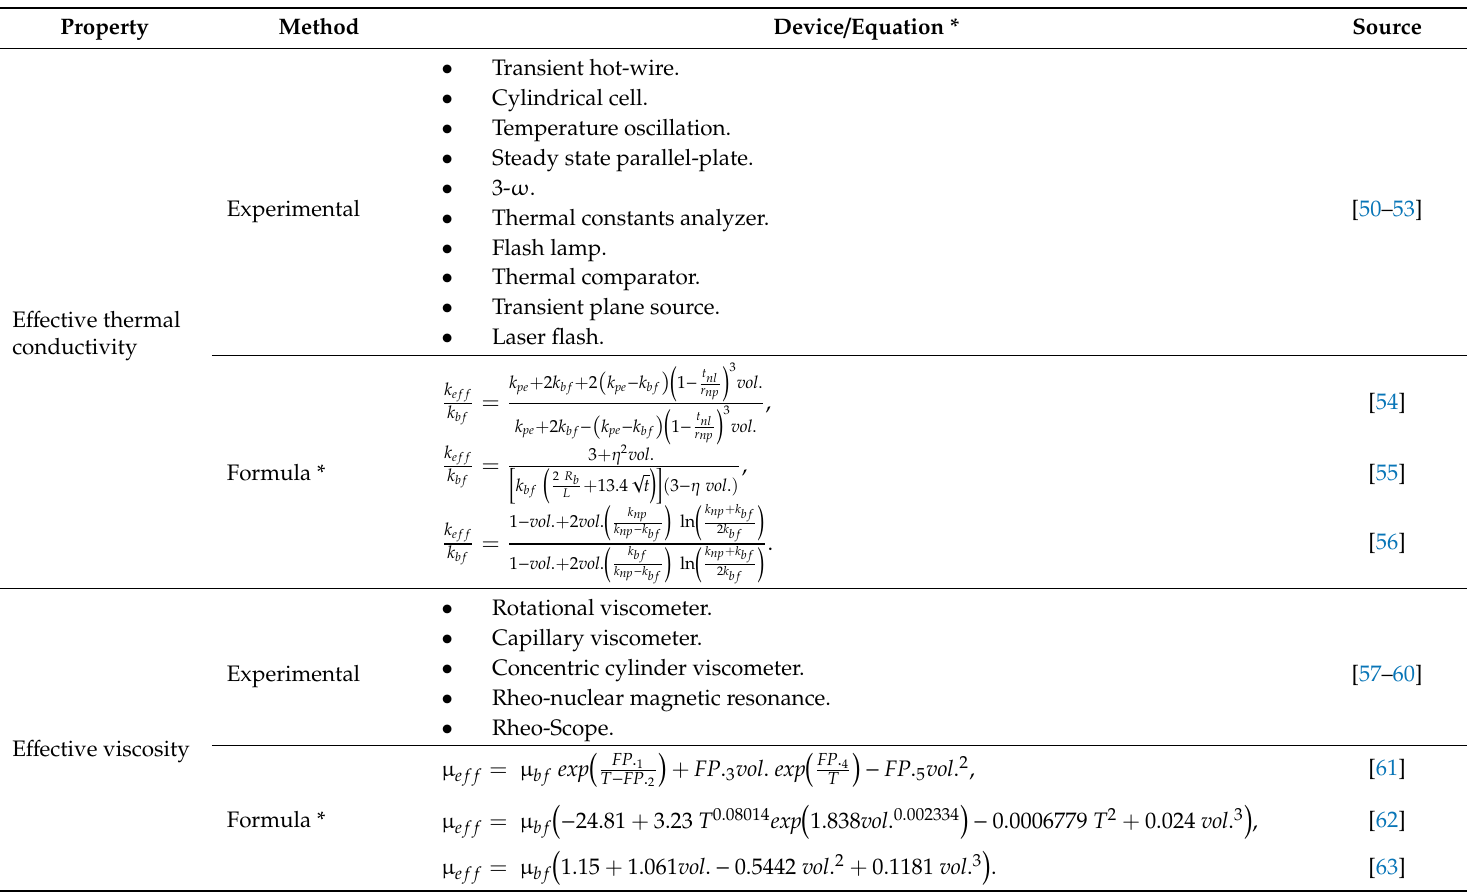
Table 2. Selected e ff ective thermal conductivity and e ff ective viscosity measurement methods and theoretical